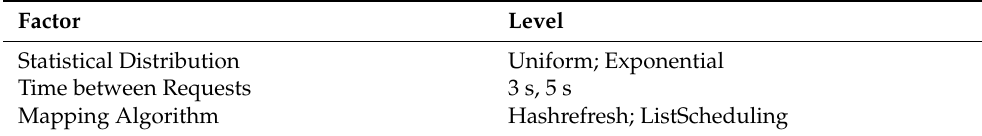
Table 3. Table of factors and